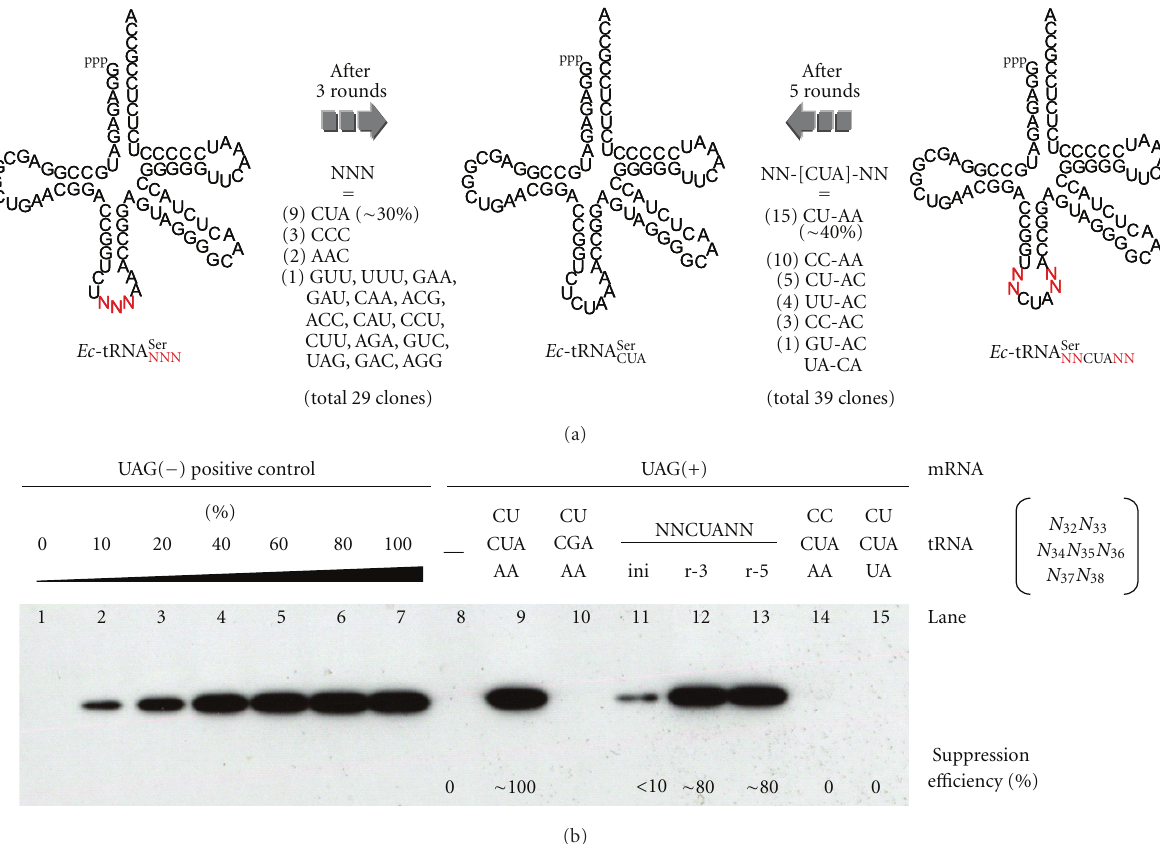
Figure 3: (a) Summary of selection/amplification of anticodon-randomized or anticodon-matched/anticodon-loop-randomized tRNAs for Ser. The numbers of clones that possess the sequence shown are indicated in parentheses. (b) Western blotting analysis of the translation of nonfused (tRNA-lacking) mRNA templates under normal (noncompartmentalized) conditions with (lanes 9–15) or without (lane 8) tRNA; tRNA SerU CUA (lane 9), tRNA SerU CGA (natural tRNA for Ser, lane 10), anticodon-loop-randomized tRNA SerU after 0, 3, or 5 rounds of selection/amplification (lanes 11, 12, or 13, respectively), or anticodon-matched but singly loop-mutated tRNA SerU (lanes 14 and 15). Lane 7 represents a control translation using amber-free mRNA with no use of tRNA as a positive control and lanes 1–7 are a calibration set.